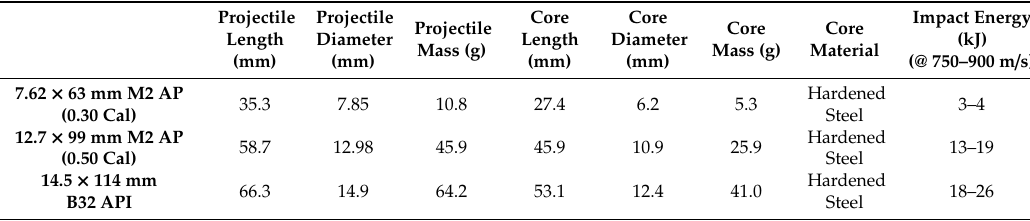
Figure 5. Cross section drawing of the ( a ) 7.62 × 63 mm M2 AP, ( b ) 12.7 × 99 M2 AP, and ( c ) 14.5 × 114 mm B32 armor-piercing incendiary (API) projectiles [46] that are used for testing CMF armors. Table 1. Projectile and core size for each of the tested ballistic rounds and their associated impact energies